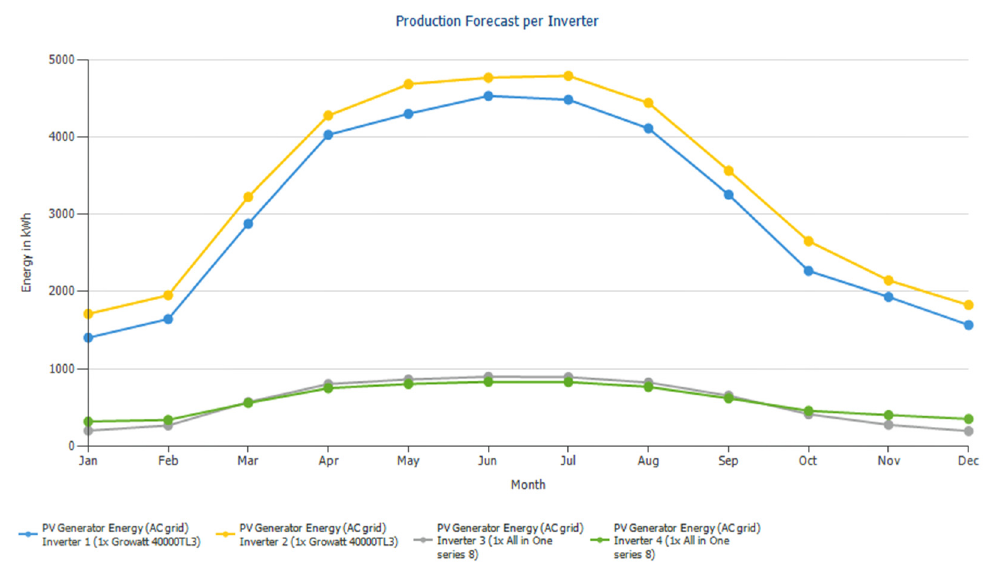
Figure 10. Inverter group outputs.